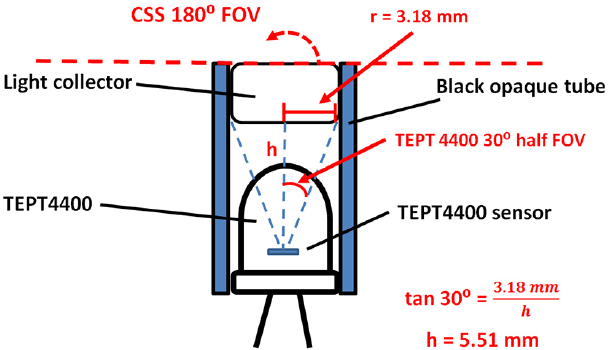
Figure 5. Cross-sectional view of luminance sensor optical assem- bly (TEPT4400, opaque tube, and light collector/diffuser) for a ver- tical spacing h that matches the TEPT4400 field of view (FOV) to the diffuser diameter. To reduce the effect of TEPT4400 sensor tilt errors, h = 2.98mm was chosen